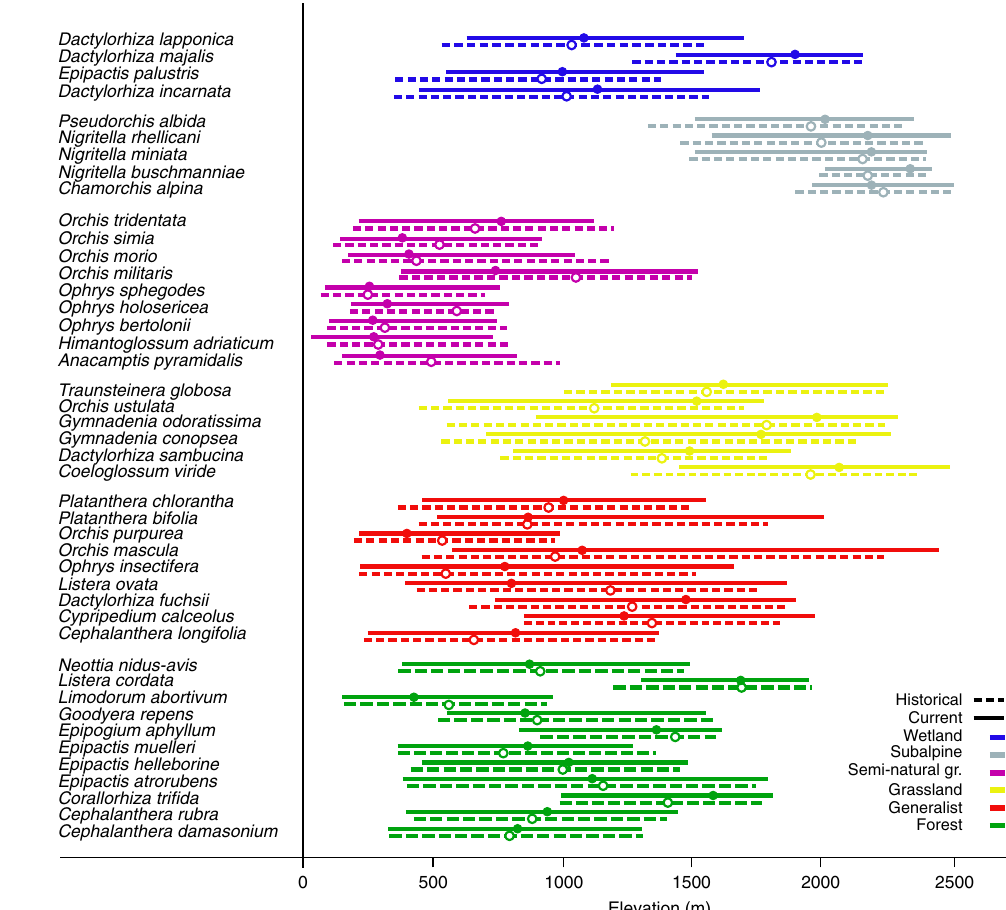
Fig. 3 Orchid elevational distribution. Elevational distribution for the orchid species with at least 30 distribution records per period (historical, 1990 – 2003, and current, 2004 – 2017) pooled by habitat preference. Dashed bars represent historical (1990 – 2003) and solid bars current (2004 – 2017) rear (5%) and leading edges (95%), points represent optima (highest peak) of the density distribution.